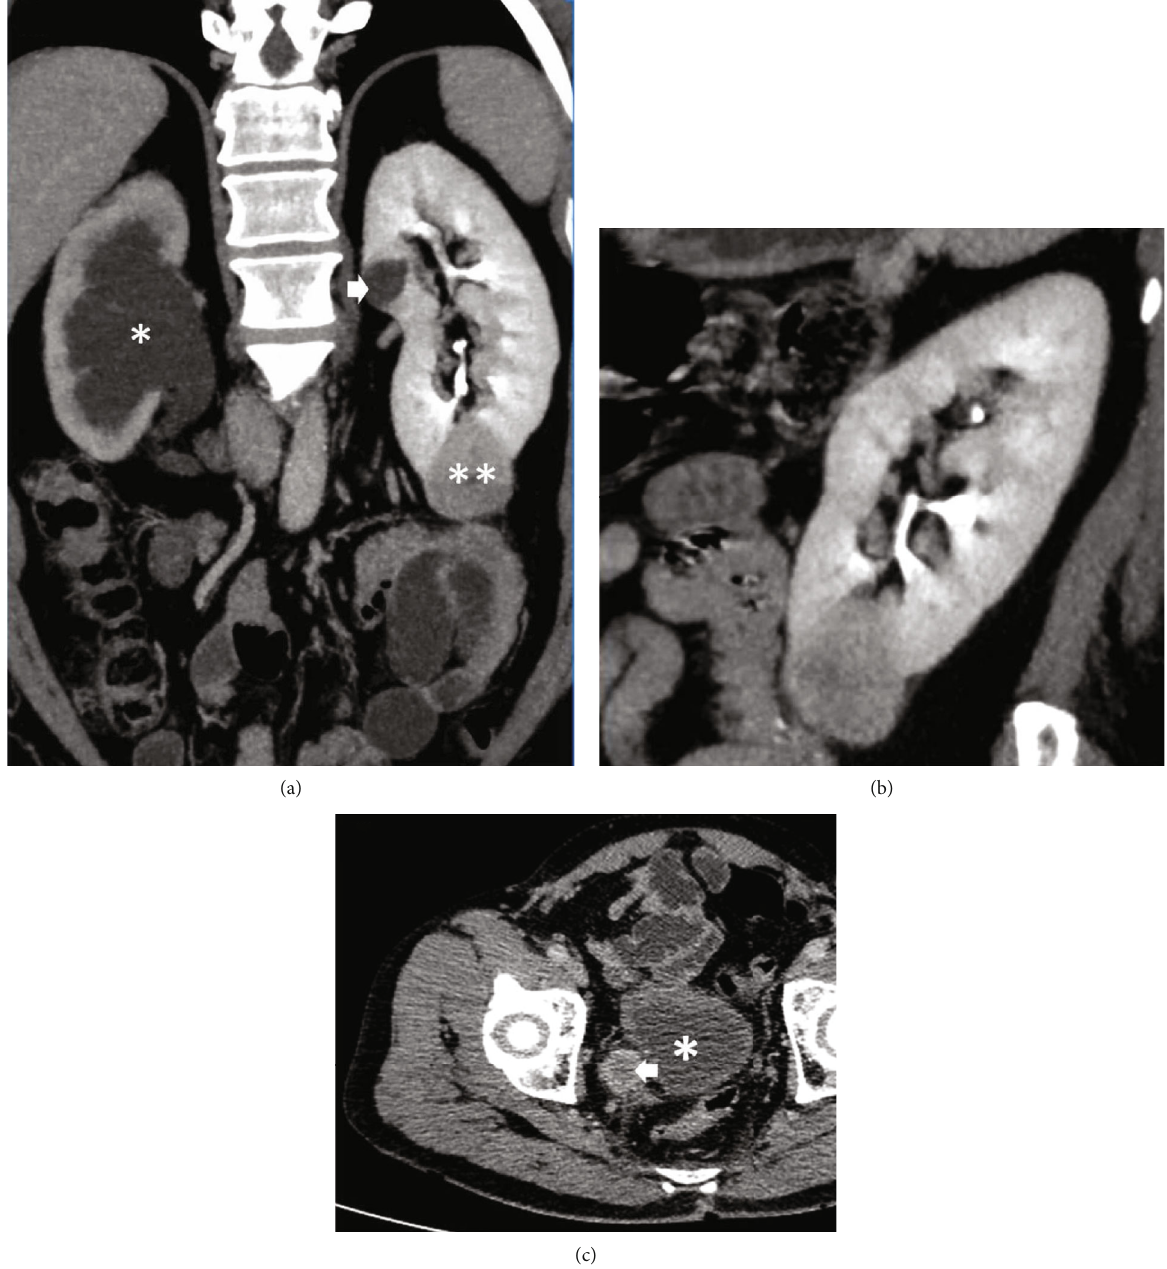
Figure 1: CT images of the patient. (a) A coronal section illustrating the hydronephrotic right kidney ( ∗ ) due to the obstruction caused by the lower ureteric tumour and the left kidney with a contrast enhancing mass in the lower pole ( ∗∗ ) and a simple cyst in the upper pole (arrow). (b) A coronal section through the left renal mass. (c) An axial section showing the right ureteric tumour (arrow) in relation to the posterior wall of the bladder ( ∗